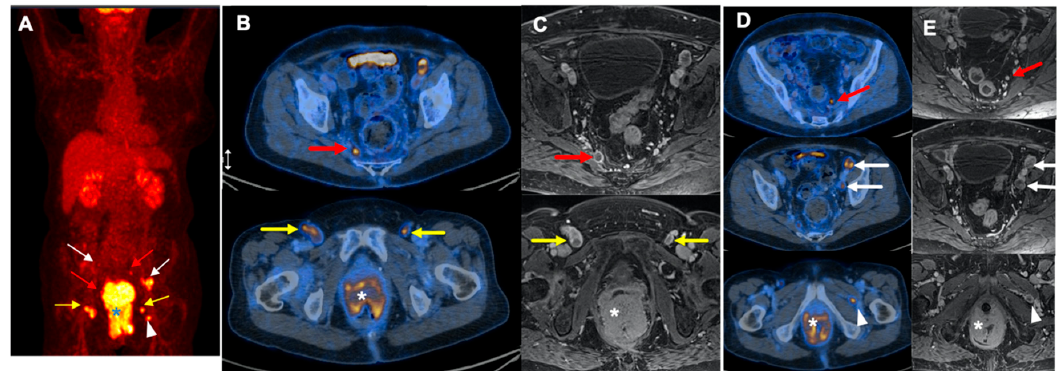
Figure 4. A 77-year-old female with T4N1cM0 disease. ( A ): MIP: maximum intensity projection and ( B ) and ( D ): (transverse fused PET/CT images): Aside from the primary tumor (*), there are multiple metabolically active lymph nodes in bilateral internal iliac (red arrows), external iliac (white arrows), and inguinal (yellow arrows) regions. Also, an intermuscular lymph node is visualized in near the left external obturator muscle (white arrow head). ( C ) and ( E ): MRI (magnetic resonance imaging), Axial T1 weighted flash3d vibe fatsat Sequence shows corresponding morphological changes (arrows).